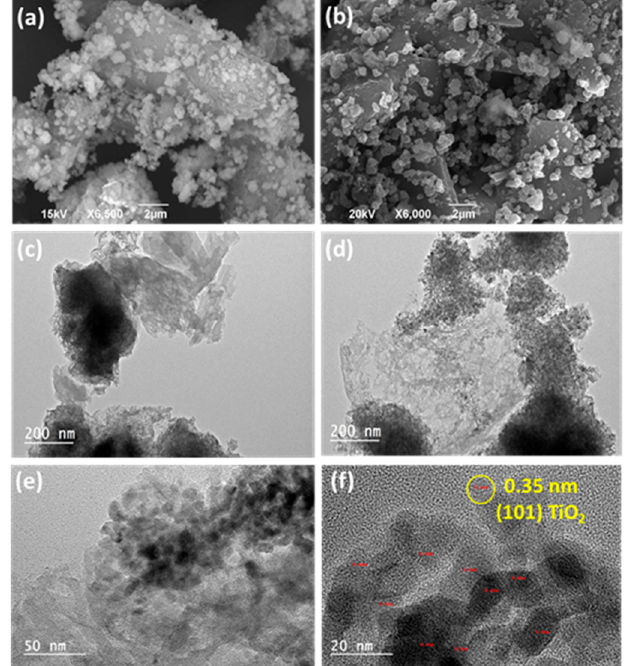
Figure 2. Scanning electron microscopy (SEM) images of ( a ) g-CN/MIL-125 (3:2) and ( b ) g-CN/TiO 2 (3:1), transmission electron microscopy (TEM) images of ( c ) g-CN/MIL-125 (3:1), and ( d–f ) g-CN/TiO 2 (3:1) composites.